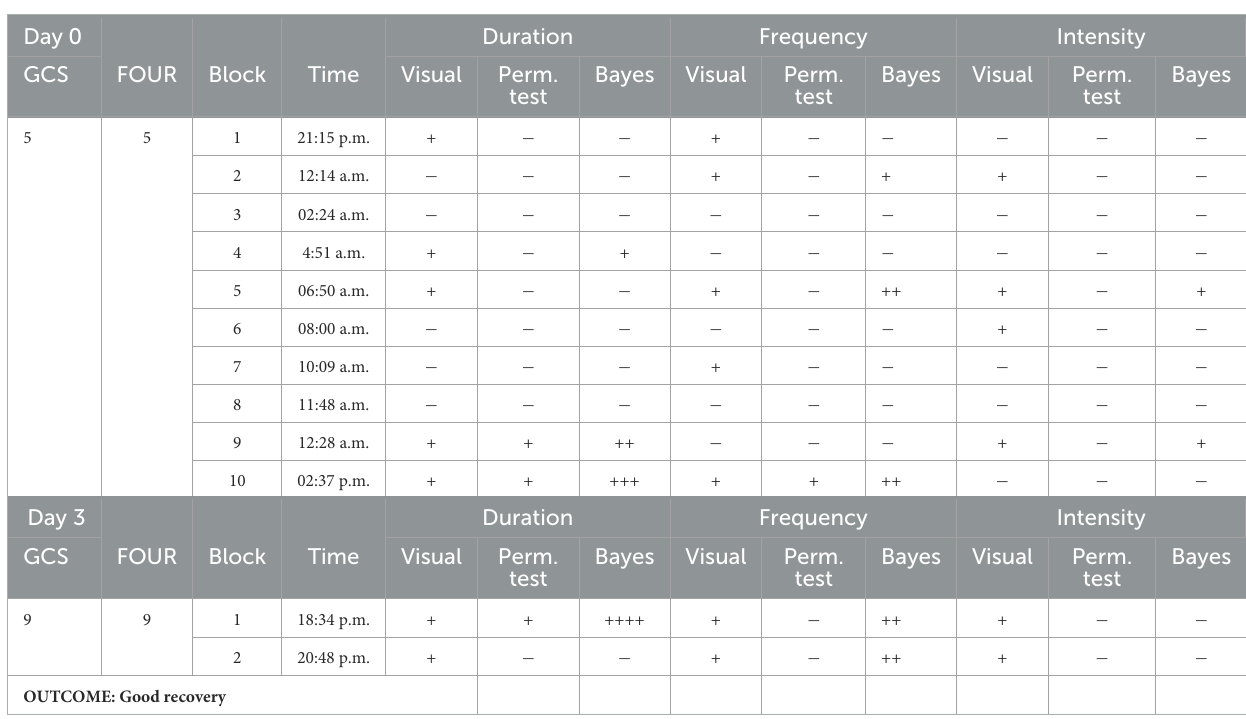
TABLE 5 Summary of the MMN results in Patient 2. Day 0 Duration Frequency Intensity GCS FOUR Block Time Visual Perm.